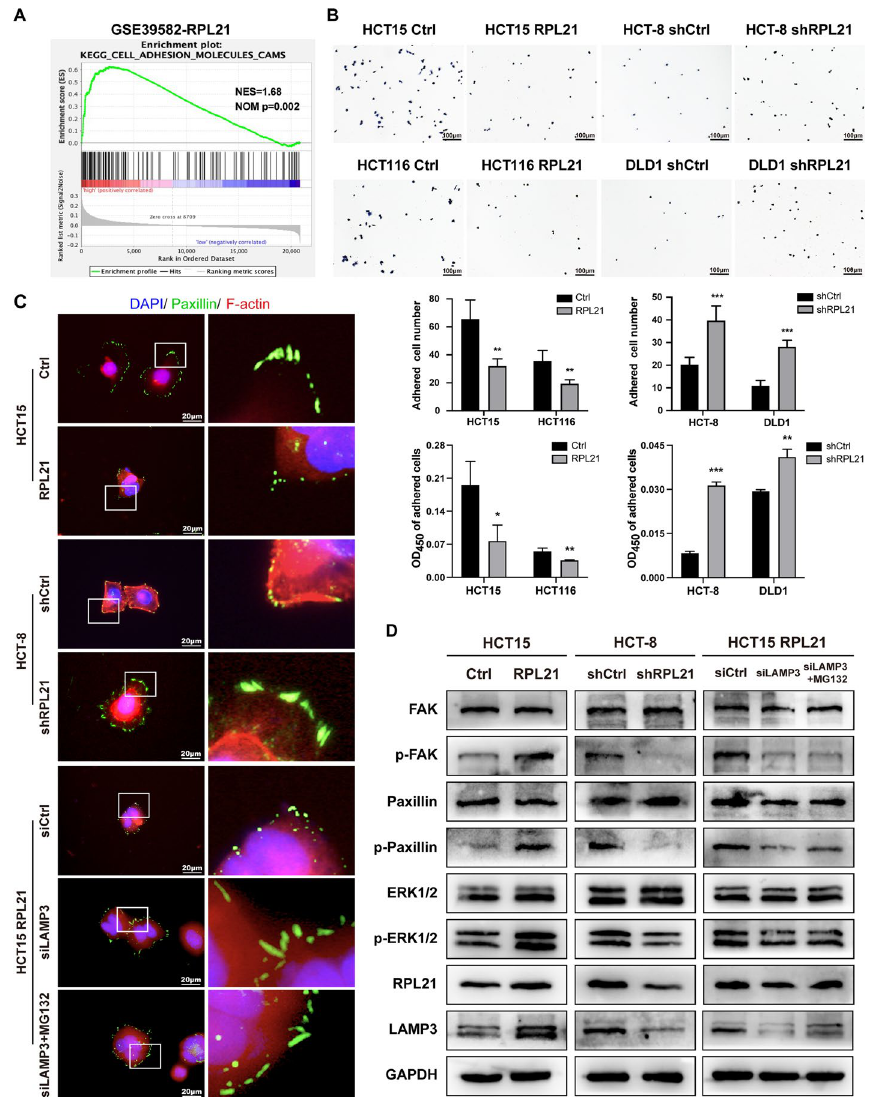
Fig. 6 RPL21–LAMP3 regulates FA formation and promotes cell spreading. A KEGG enrichment analysis of the RPL21 expression in the CRC database GSE39582. B The adhesion ability of the indicated cells was detected by the FN adhesion assay (scale, 100 μm). Mean SD, n 5, *** p < 0.001, ** p < 0.01, * p < 0.05, ± = Student’s t -test. C The morphology of FA (paxillin, green) of the indicated cells was observed by IF staining (scale, 20 μm). D FAK, pTyr397-FAK, paxillin, pTry118-paxillin, ERK1/2, pThr202/Tyr204-ERK1/2, RPL21, and LAMP3 protein expression in the indicated CRC cells was detected by western